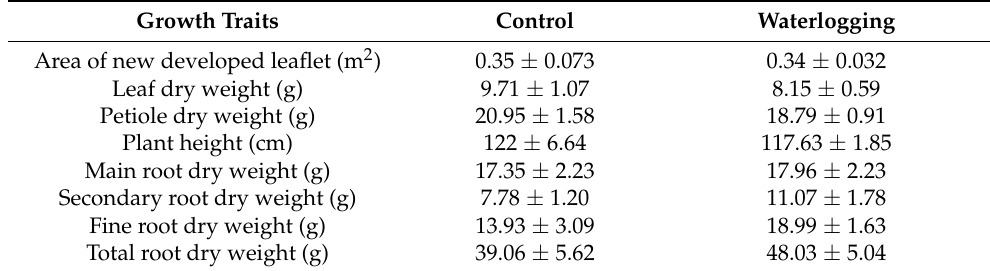
Table 1. Growth traits of sago palm seedlings for each water treatment (control and waterlogging). Growth Traits Control Waterlogging Area of new developed leaflet (m 2